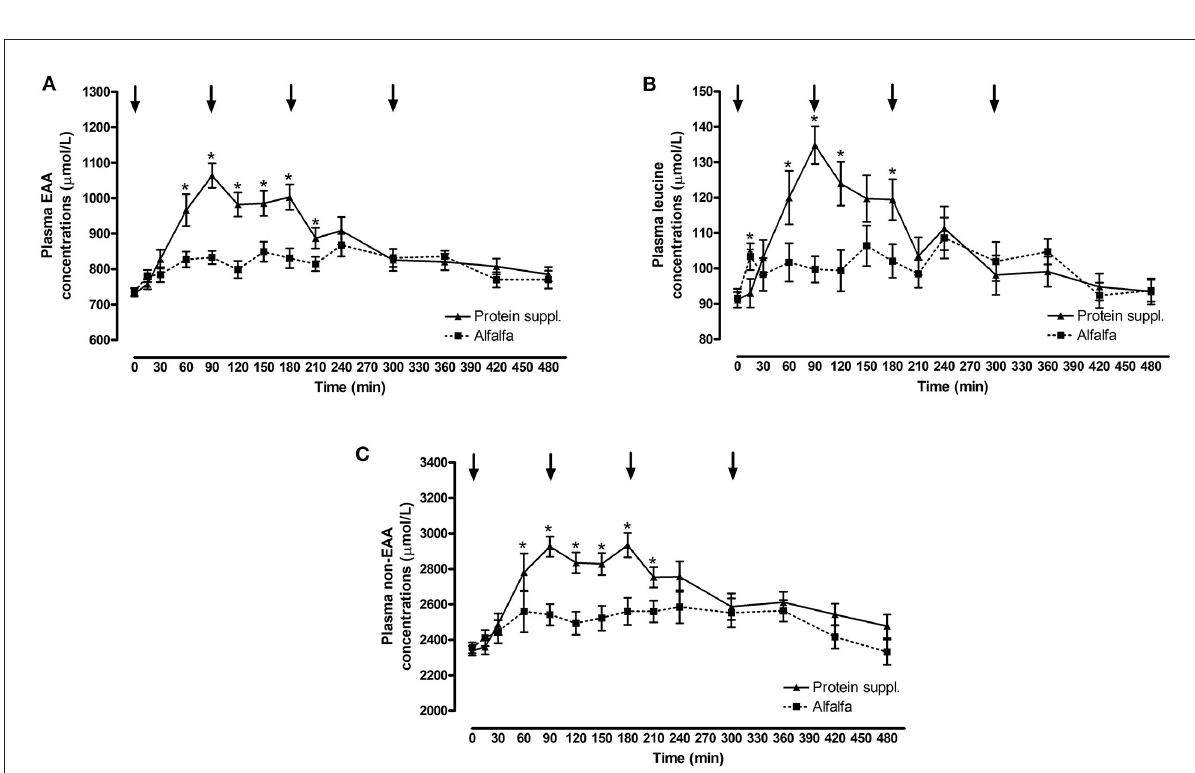
FIGURE2 Plasma essential amino acids, leucine and non-essential amino acid responses over time after consumption of a protein supplement or alfalfa pellets. Effect of treatment by time interaction on plasma essential amino acid (EAA, A ), leucine (B) and non-essential amino acids (non-EAA, C ) concentrations post consumption of the protein supplement (solid line, n = 16) and alfalfa pellets (dashed line, n = 14) in all horses. Black arrows indicate timepoints of muscle biopsy. * Indicates differences between treatments within a timepoint. Effect of treatment by time interaction, EAA: P < 0.0001; leucine: P < 0.0001; non-EAA: P = 0.007. Data presented as least square means ± standard error of the mean.